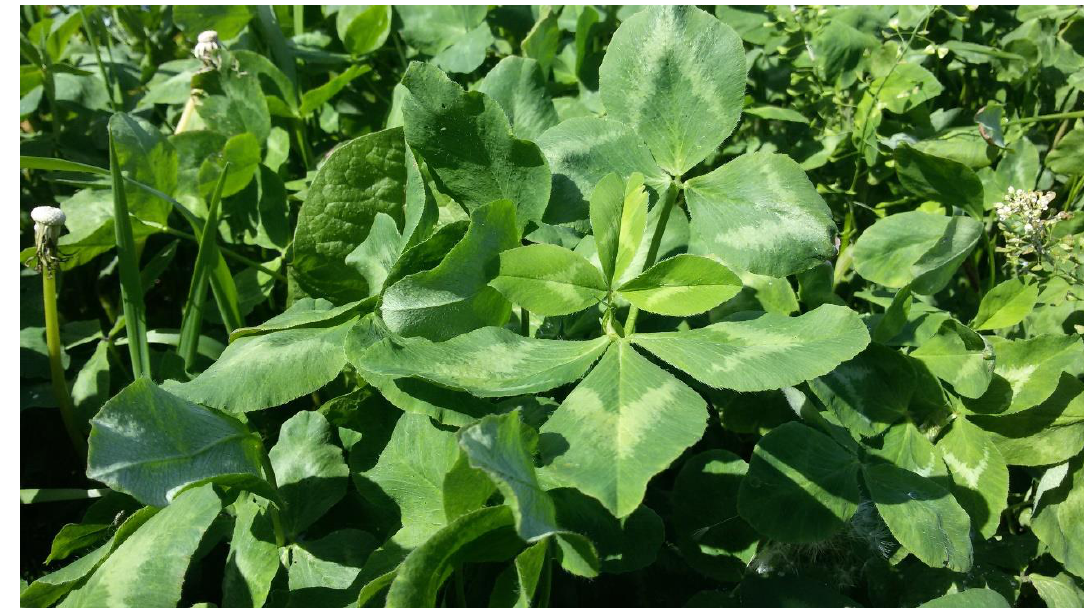
Figure 4. Trifolium pratense L. growing on the experimental plot.